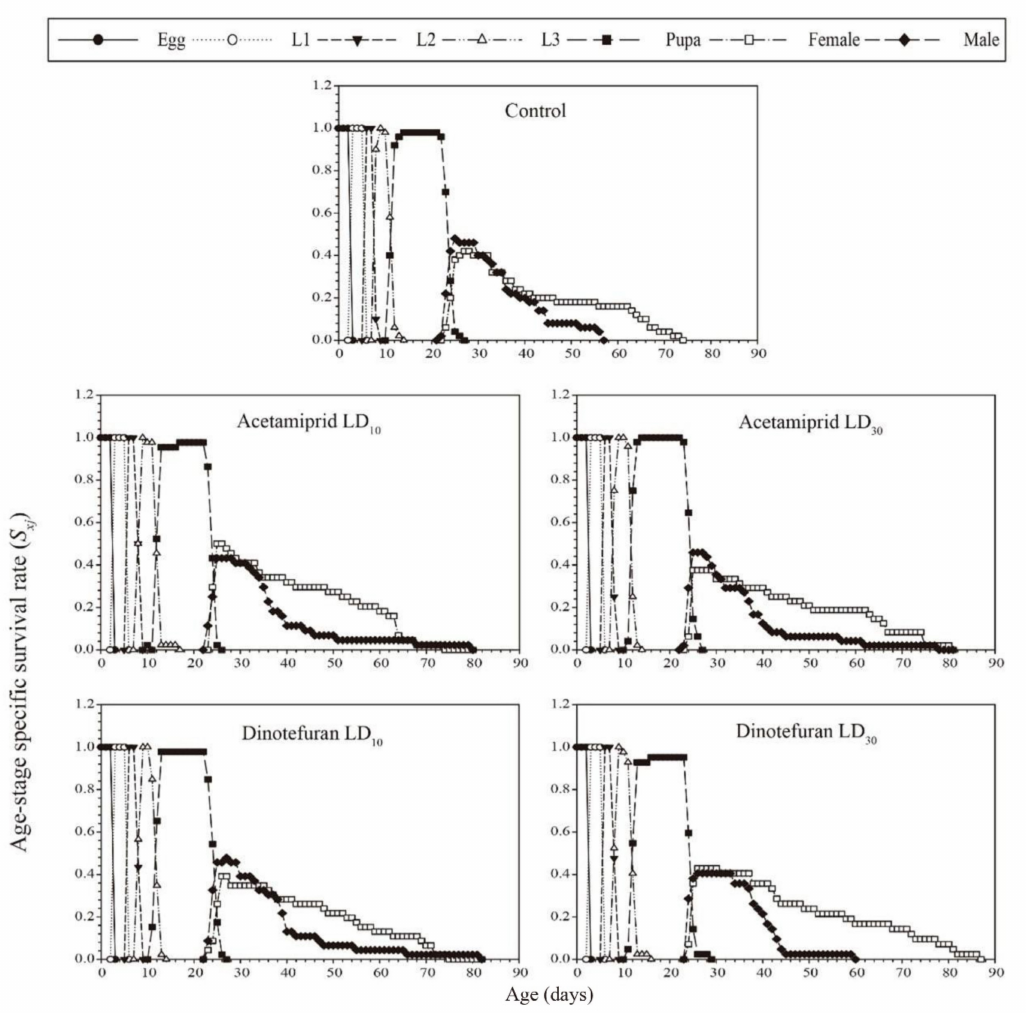
Figure 1. Age-stage-specific survival rate ( Sxj ) of C. pallens for 2nd instar C. pallens larvae exposed to sublethal acetamiprid and dinotefuran